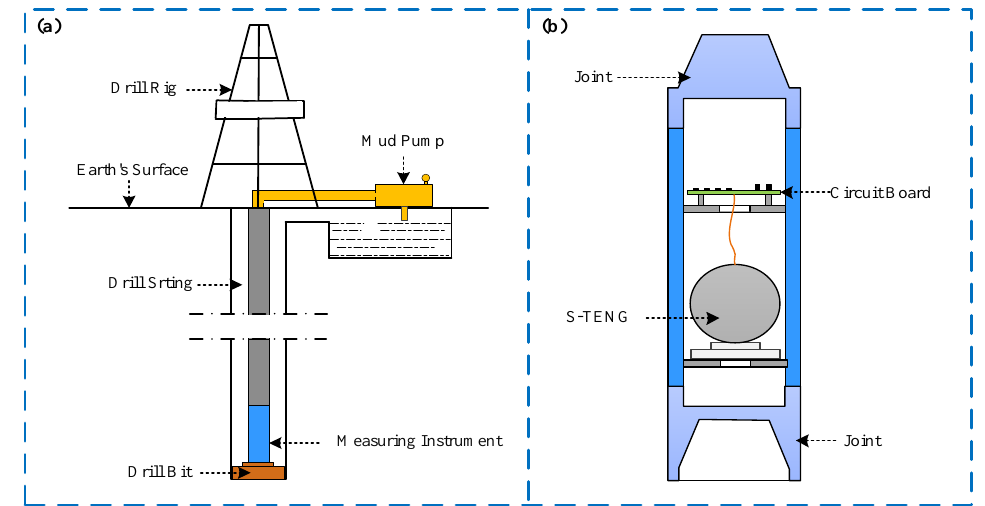
Figure 1. Installation location of the S-TENG (spherical triboelectric nanogenerator). ( a ) Installation location in the downhole; ( b ) Enlargement diagram of the measuring instrument.